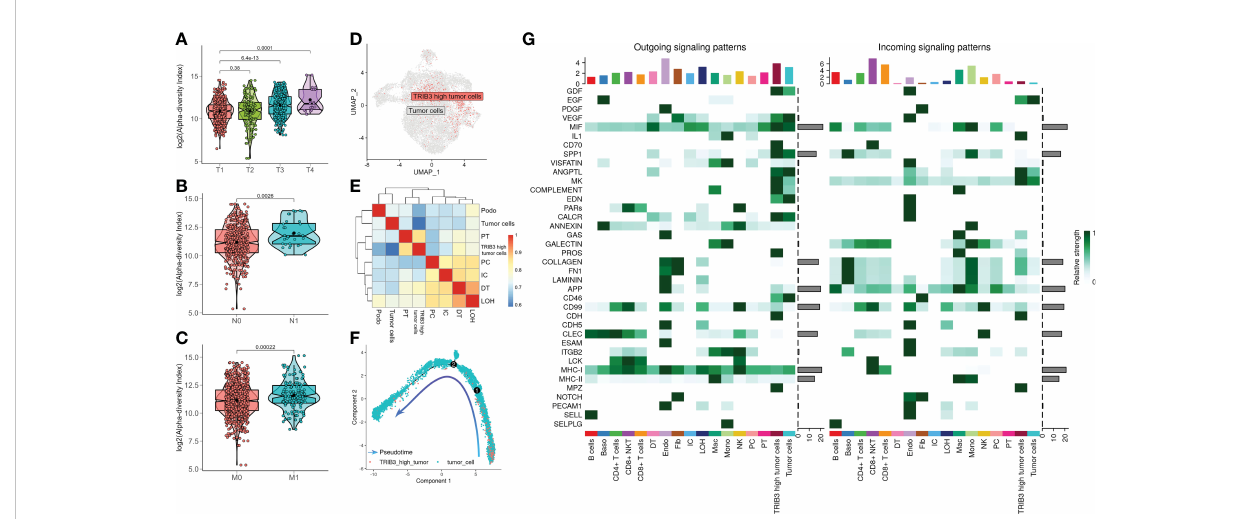
FIGURE 6 Clinical characteristics of TRIB3 expression in kidney renal clear cell carcinoma (KIRC) patients and characterization of the TRIB3 high tumor cell subset. (A – C) The box plot shows the correlation between TRIB3 expression and T classi fi cation, N classi fi cation, and M classi fi cation in KIRC patients. (D) Uniform manifold approximation and projection plot indicating the distribution pattern of TRIB3 high tumor cells. (E) Heat map showing the correlation between various cell types using the Spearman method; the colors represent the strength of the correlation. (F) Pseudotime analysis of TRIB3 high tumor cells. The direction of the arrow indicates the differentiation trajectory. (G) Signaling role analysis showing the aggregated cell – cell communication networks from all signaling pathways. The shades of color represent the relative strength of cellular